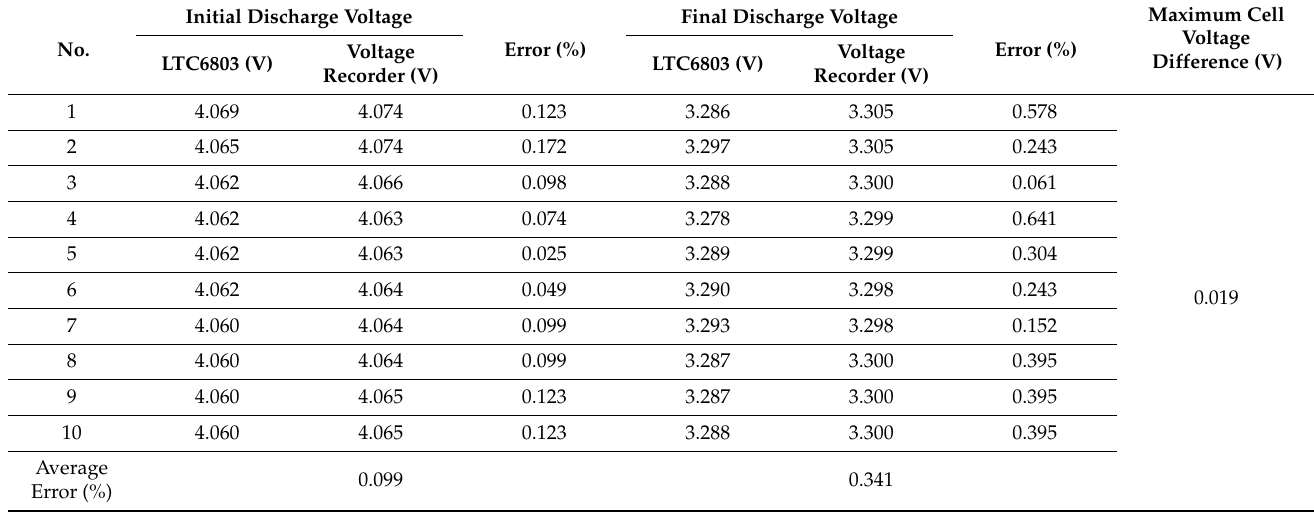
Table 3. Error comparisons of discharge voltage